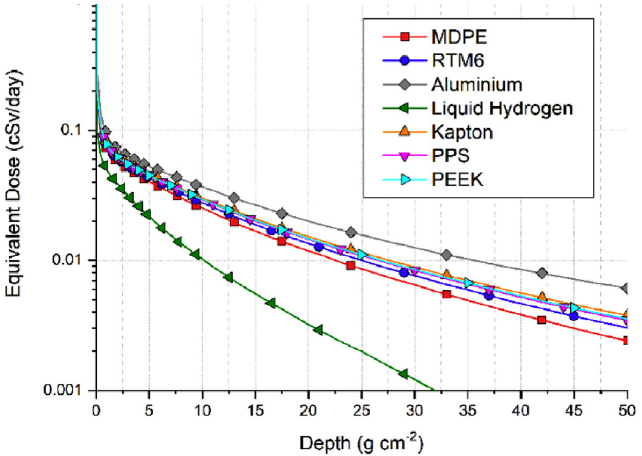
Figure 20. The equivalent dose of galactic cosmic rays for different materials in the LEO environment with an inclination of 51.6° recorded during 2015 [163].